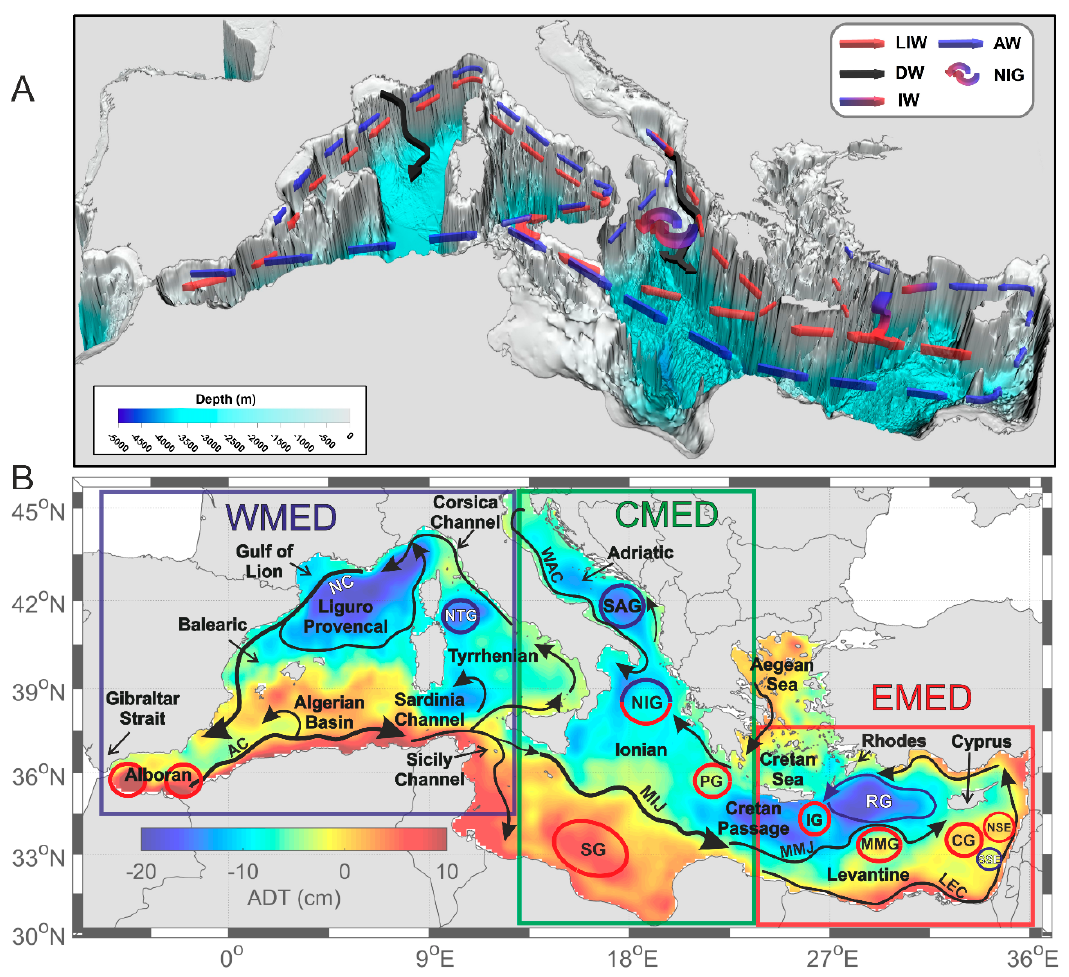
Figure 1. ( A ) Schematic representation of the thermohaline circulation in the Mediterranean Sea where the intermediate and deep-water formation sites are highlighted. ( B ) Geography of the Mediterranean Sea superimposed on the colored mean ADT map for 1993–2019; a schematic representation of the main currents and circulation structures are depicted with black arrows and red (anticyclonic) and blue (cyclonic) circles; geographical extension of the three main sub-basins (WMED, CMED, and EMED). Acronyms: AW, Atlantic Water; LIW, Levantine Intermediate Water; DW, dense water; IW, Intermediate Water; NIG, Northern Ionian Gyre; AC, Algerian Current; NC, Northern Current; NTG, Northern Tyrrhenian Gyre; SG, Sidra Gyre; MIJ, Mid-Ionian-Jet; SAG, Southern Adriatic Gyre; WAC, Western Adriatic Current; PG, Pelops Gyre; MMJ, Mid-Mediterranean Jet; LEC, Libyo-Egyptian Current; IG, Ierapetra Gyre; RG, Rhodes Gyre; MMG, Mersa-Matruh Gyre; CG, Cyprus Gyre; SSE, South Shikmona Eddy; and NSE, North Shikmona Eddy.